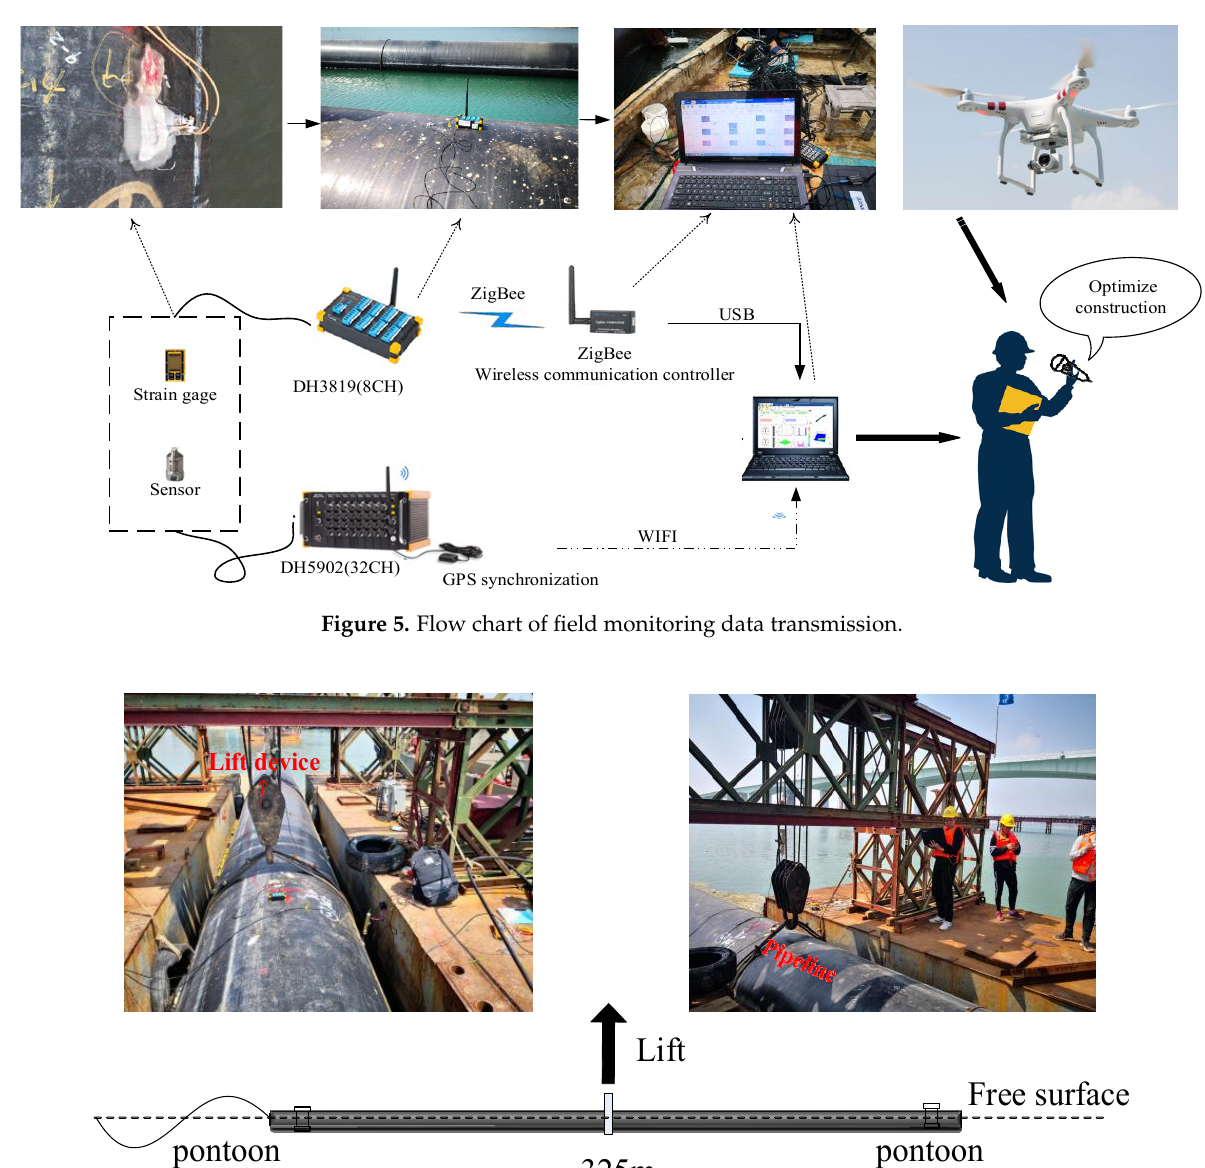
Figure 6. Lifting test on site. Table 1. Lifting test